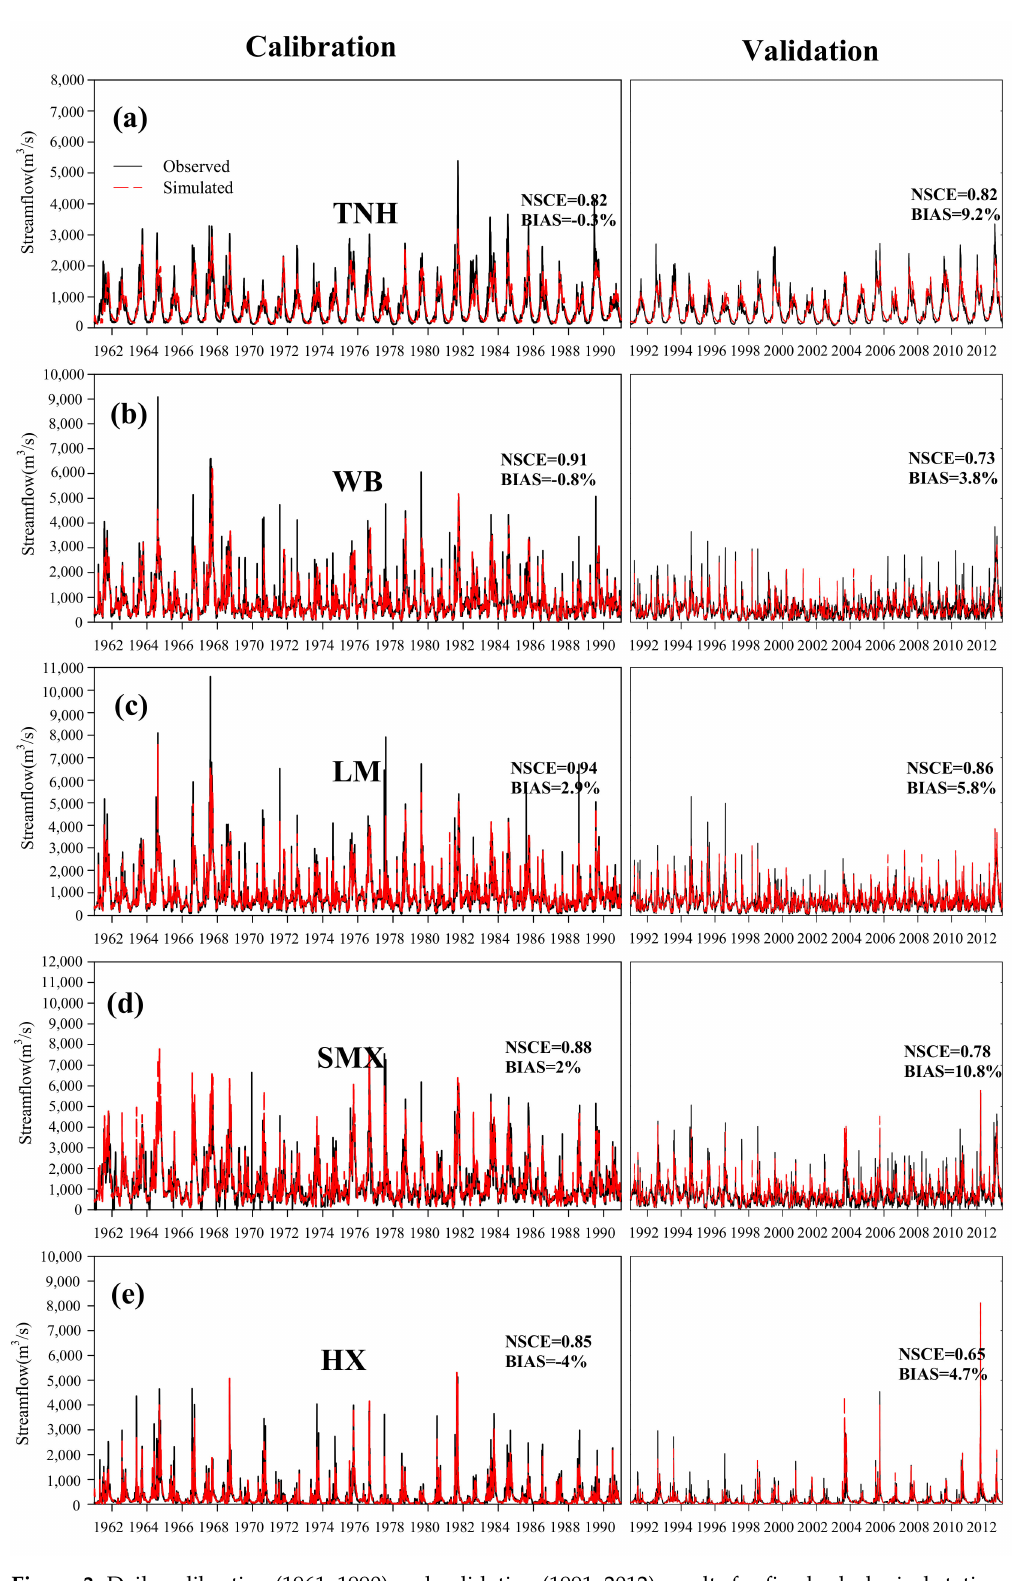
Figure 3. Daily calibration (1961–1990) and validation (1991–2012) results for five hydrological stations situated at the ( a ) upper, ( b – e ) middle and downstream parts of